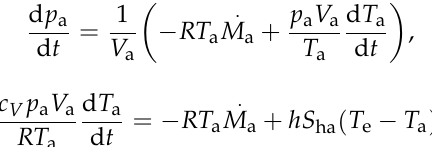
Figure 12. Pneumatic circuit for testing the heat transfer coefficient h : (a) Schematic diagram; (b) Test platform.